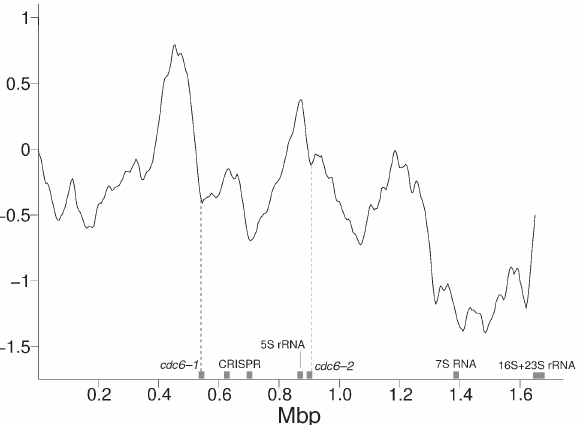
Figure 2. A GC-skew analysisof the H. butylicus genome showing the major peaks where nucleotide compositionaldeviationsoccur. Shown below are some of the main features of the genome including the two cdc6 genes, rRNA genes and large repeat clusters (CRISPR). The or- dinate scale is arbitrary, showing positive and negative G/C devia- tions. The abscissa corresponds to the genome sequence length where thenumberingstartsjustupstreamfromthe16S + 23S rRNA